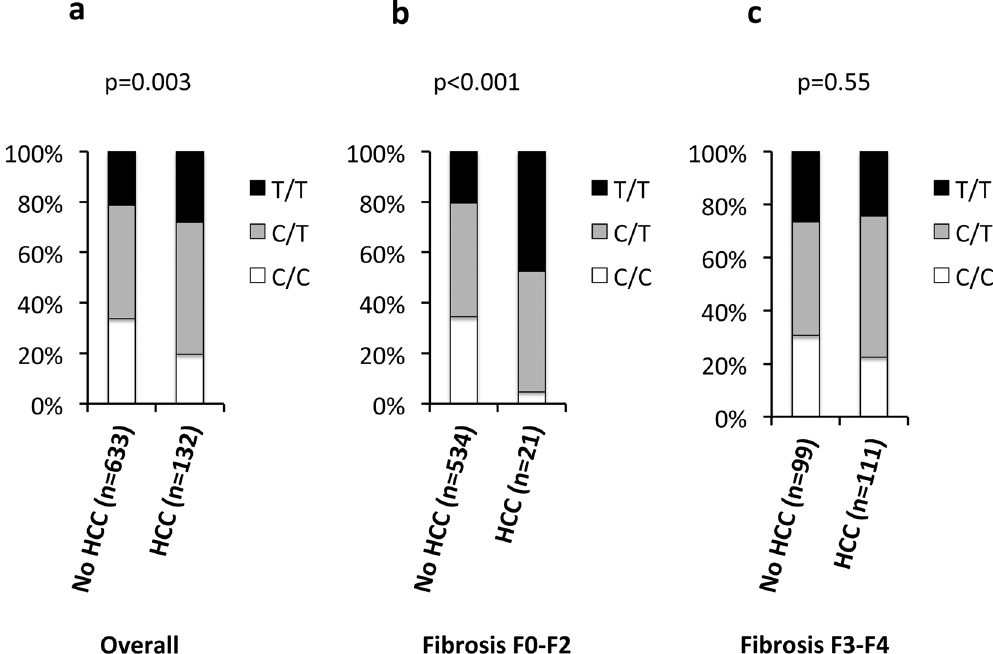
Figure 1. Frequency distribution of the MBOAT7 locus rs641738 T allele in 765 Italian NAFLD patients stratified by the presence of hepatocellular carcinoma (HCC). ( a ) Overall cohort; ( b ) patients with stage F0-F2 fibrosis; ( c ) patients with stage F3-F4 fibrosis. Comparisons were performed by logistic regression setting HCC as dependent variable, and the association with the MBOAT7 variant was analyzed assuming an additive